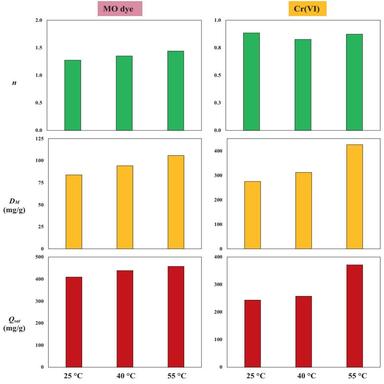
Calculated steric parameters for the Cr(VI) and MO adsorption on Mus/St/MNPs.